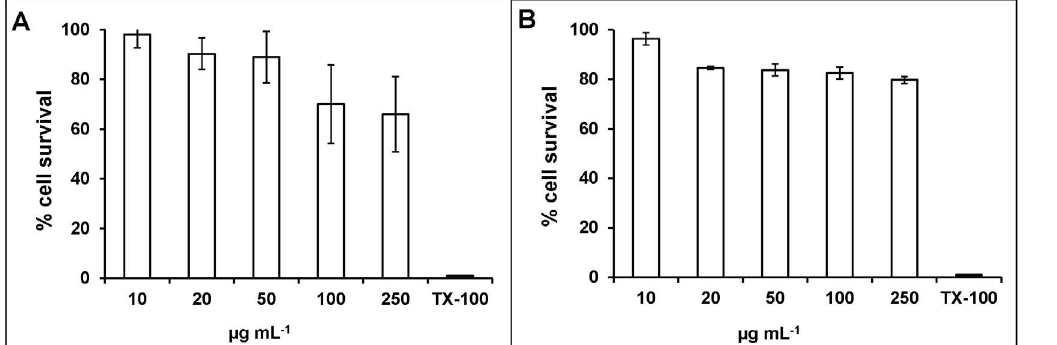
Figure 8. Mammalian cell cytotoxicities of FG08. MTT-based cytotoxicity assays were performed with NIH3T3 mouse fibroblast (A)) and C8161.9 melanoma (B) cells with 24 h exposure to FG08 (filled bars) at various concentrations. The positive control (100% cytotoxicity=no cell survival) was provided by treatment with Triton X-100 (1% vol vol 2 1 ) (open bar). Error bars represent data combined from three separate experiments.